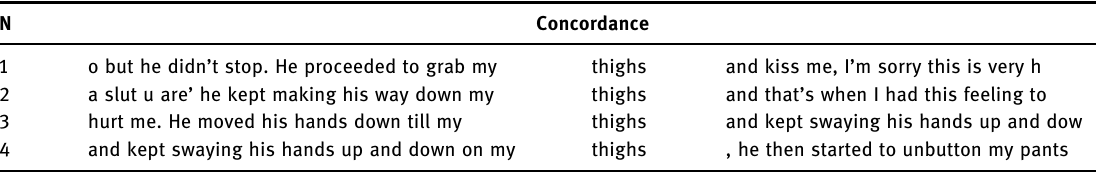
Table 46: Concordance lines for